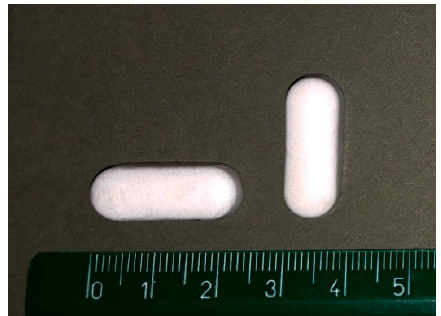
Figure 1. Appearance and dimensions of the freeze-dried bigels.